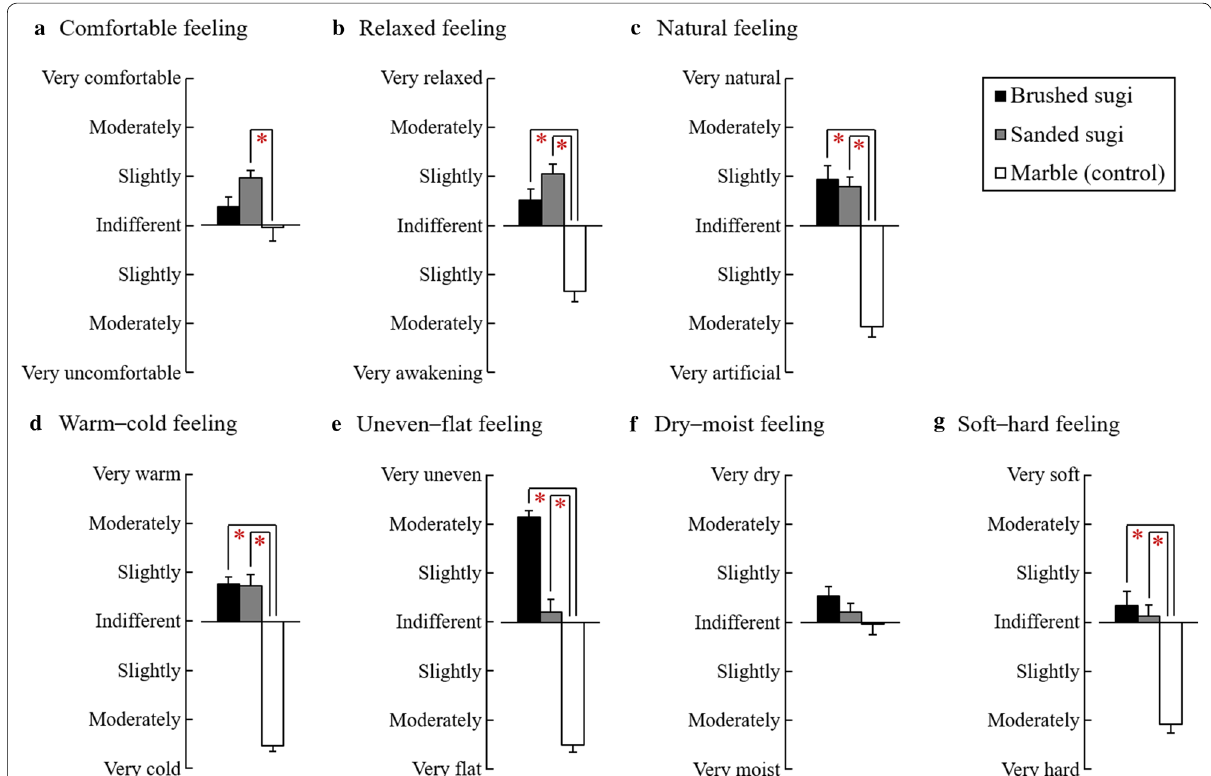
Fig. 4 Subjective evaluation using the modified semantic differential method after contact of materials via the palm of the right hand. a Comfortable feeling, b relaxed feeling, c natural feeling, d warm–cold feeling, e uneven–flat feeling, f dry–moist feeling, and g soft–hard feeling. N 21, mean standard error, * p < 0.05 as determined by using the Wilcoxon signed-rank test (one-side) with Holm correction = ±